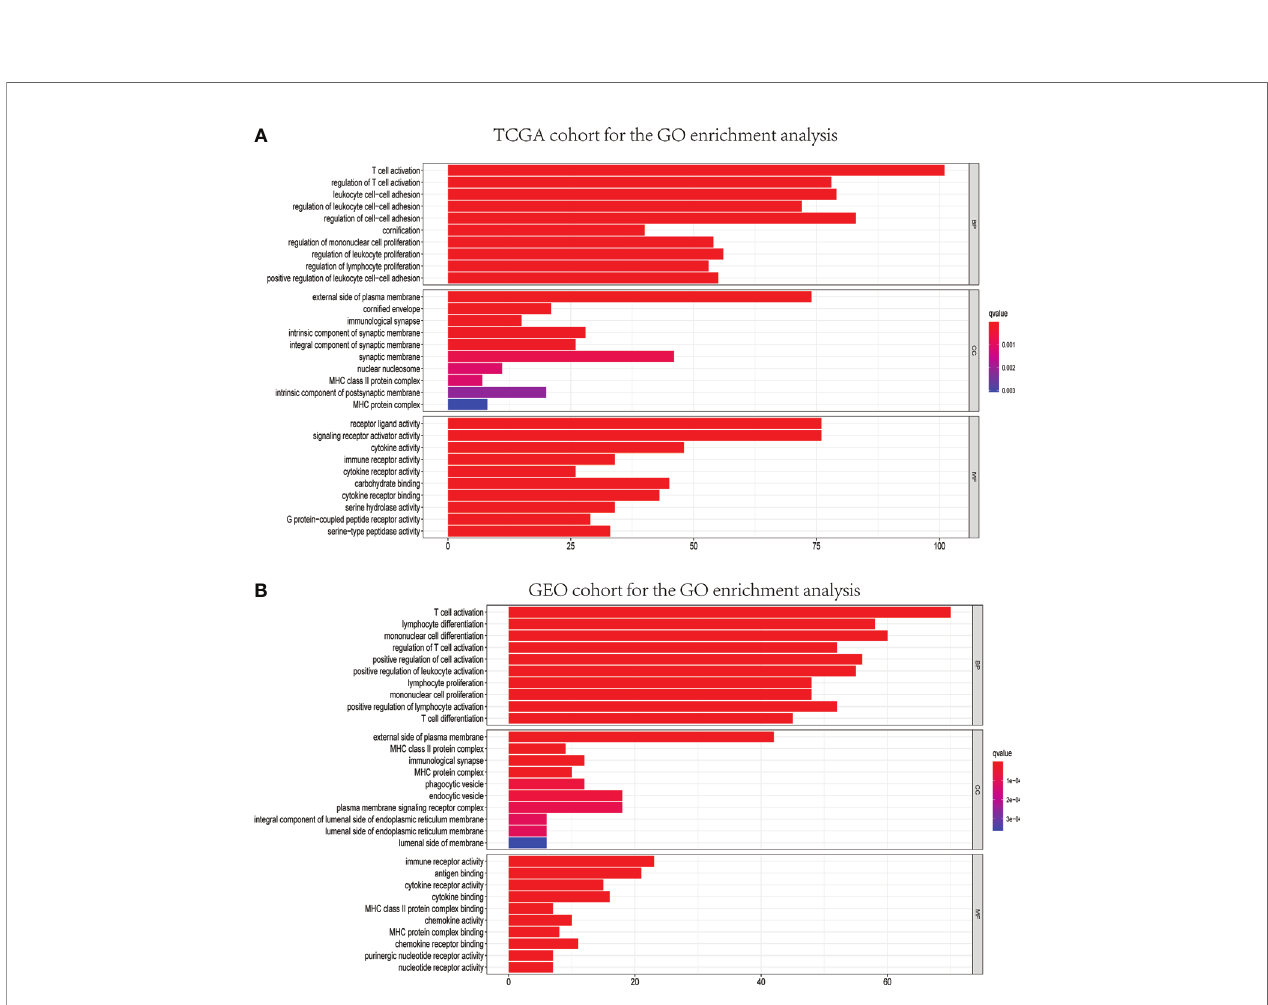
FIGURE 7 | Representative results of GO enrichment analysis in TCGA and GEO databases. The results of GO biological process enrichment, GO cellular component enrichment, and GO molecular function enrichment of DEGs between different risk groups in TCGA (A) and GEO (B)